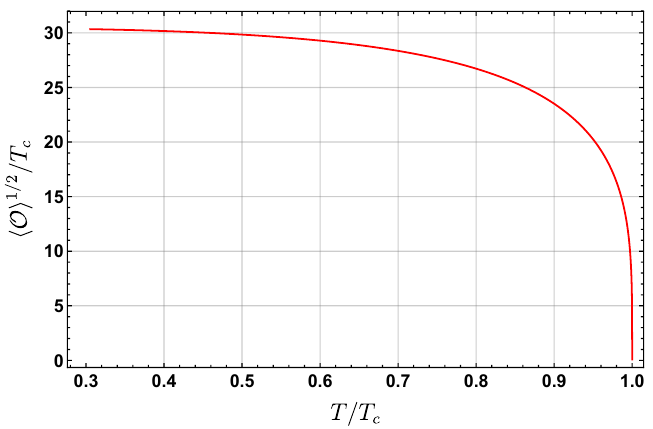
Figure 2 . The superconducting condensate hOi as a function of temperature. Below T c ≈ 0 . 0208 µ , hOi appears spontaneously from a second order phase transition. We work in the grand canonical